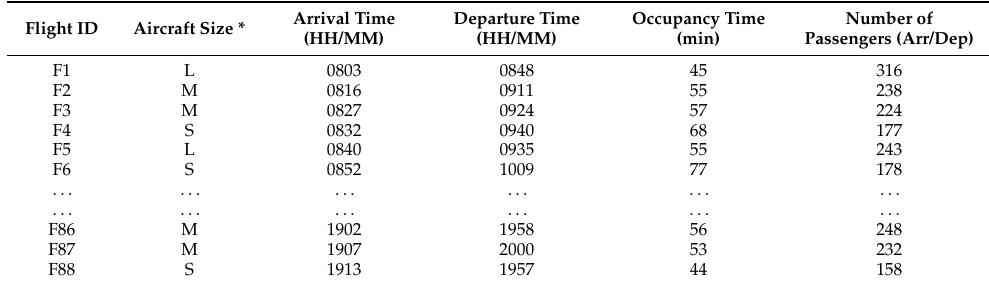
Table 3. Basic information of flight data.